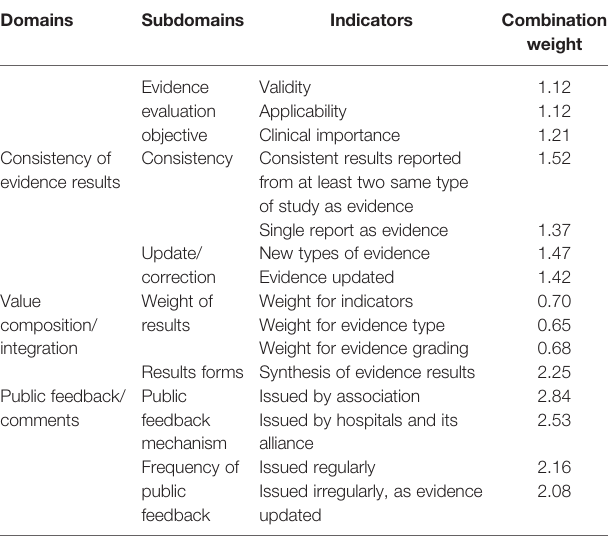
TABLE 5 | Value assessment index